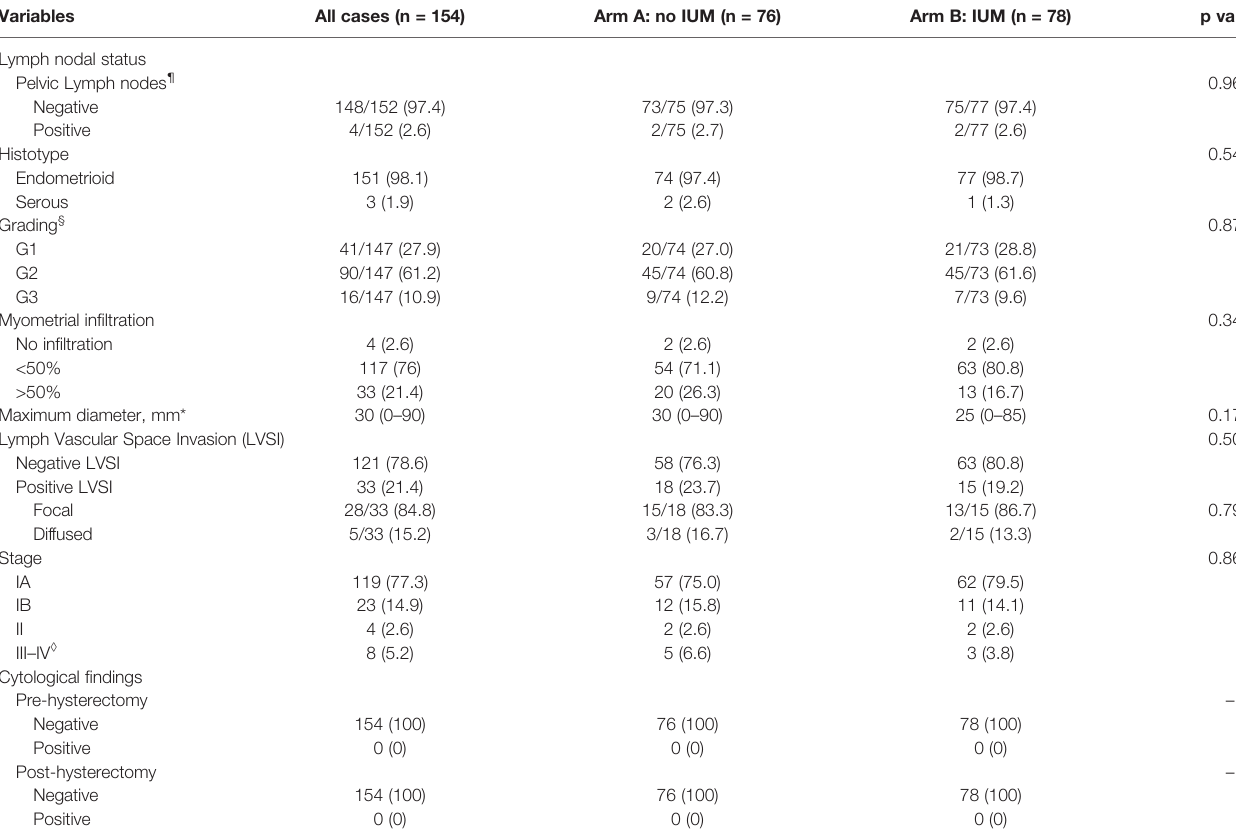
TABLE 3 | Pathological fi ndings.